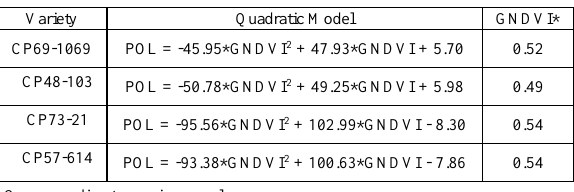
Table 1. The Quadratic equation and appropriate GNDVI value of each variety